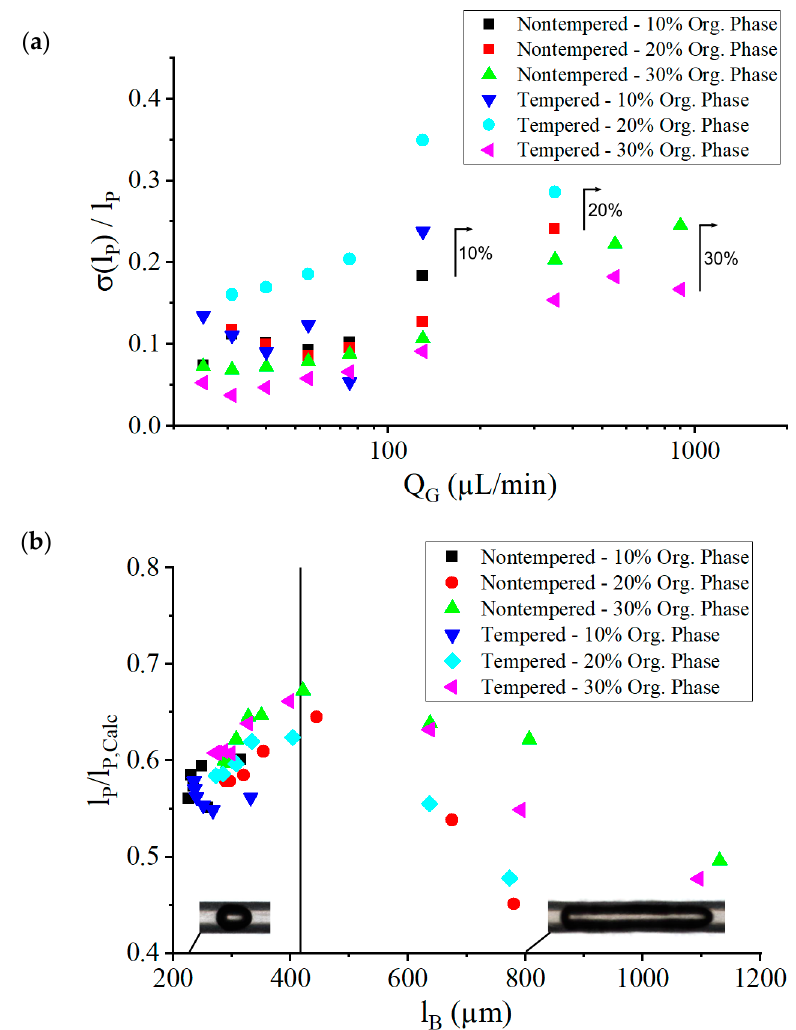
Figure 8. ( a ) The standard deviation of the plug length normalized to the average plug length dependent on the gas volume flow rate Q G . A steep increase is observed at Q G = 130 µ L/min. The three marking lines define the onset of Taylor flow instability, with increasing gas volume flow rate Q G at the respective concentrations of the organic phase. ( b ) Ratio of optically measured plug size to the plug size calculated with Equation (4) without considering thin-film leakage, dependent on the bubble size l B . The total liquid volume flow rate was kept at 200 µ L/min. The vertical line at l B = 2 d Ch marks the transition from almost round bubbles to elongated bubbles, at which point l P / l P , Calc reached a maximum for 20% and 30% concentrations of the organic phase l B = 2 d Ch . This transition occurred at Q G = 130 µ L/min (see also Figure 9).